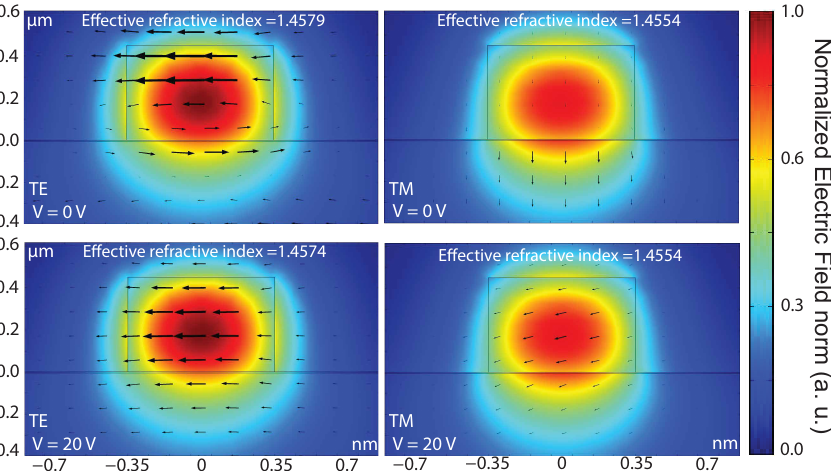
Figure 3. Electric field distribution at λ = 800 nm, with and without the impact generated by the variation of the Fermi level when V g = 20 V. In this figure it is possible to appreciate changes in the calculated field lines for the TE and TM modes, when 20 V at the gate is applied and a constant voltage of 1 V is maintained between source and drain, however, only the TE mode presents significant variation in the effective refractive index in the presence of the surface current generated by the electric field applied to the proposed